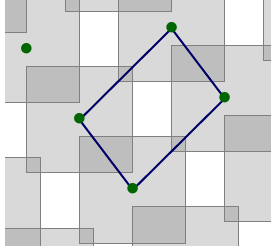
Figure 2: Geometric construction to compute the rate of injectivity: the green points are the elements of Λ , the blue parallelogram is a fundamental domain of Λ and the grey squares are centred on the points of Λ and have radii 1 / 2. The rate of injectivity is equal to the area of the intersection between the union of the grey squares and the blue